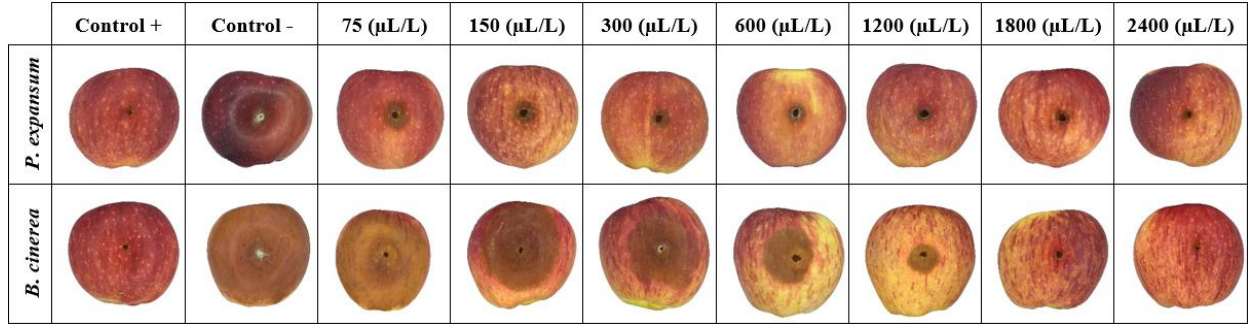
Figure 5. Digital images of apple surfaces treated with BCNCs/GelA − CEO emulsion coatings at different concentrations (75–2400 µ L/L) against P. expansum and B. cinerea , artificially inoculated into fruits, after 21 days of storage at 25 °C.